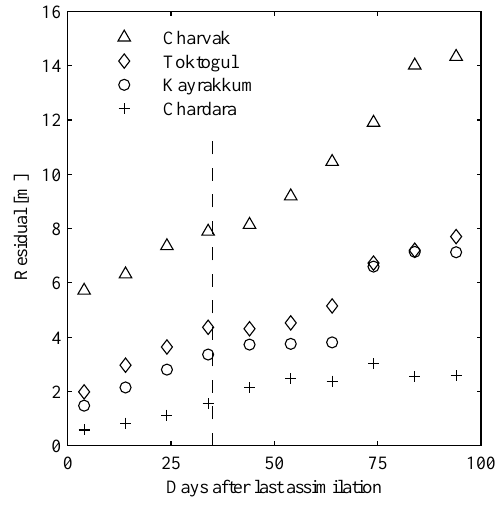
Fig. 8. Average absolute residuals of reservoir level after assimila- tion of altimetry